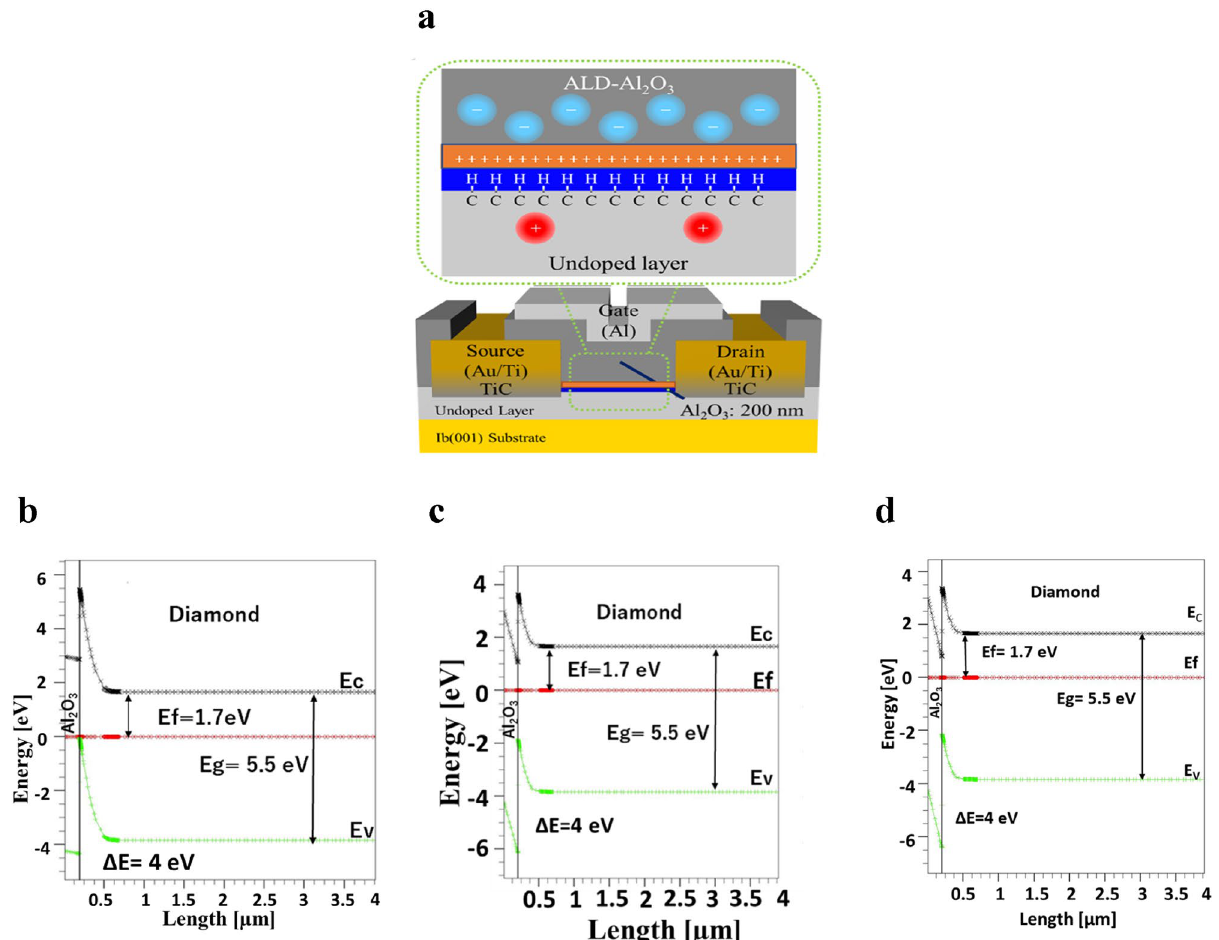
Figure 2. (a) Cross-sectional representation of the theoretical modeling 2DHG diamond MOSFET with the fixed interface charge sheet model close to surface in the FETs diamond substrate where L GD = 4 μm, L ch = 4 μm and W G = 25 μm. The upper section illustrated the negative interface charge in the ALD Al 2 O 3 . (b) , (c) , (d) The band of the C–H diamond becomes upward near the Al 2 O 3 /C-H diamond interface. In the bulk, however, Fermi level E f is fixed at 1.7 eV from the conduction band minimum corresponding to the position of nitrogen donor level (1.7 eV), which are common in the following three models withe negative, neutral, and positive interface charge sheets. (b) The negative interface charge density of 5 x 10 12 cm -2 . The valence band maximum crosses Fermi level near the Al 2 O 3 /diamond interface indicating a strong inversion layer. (c) For the no interface charge model, the valence band maximum is located at 1.8 eV from the Fermi level at the interface. It indicates a weak inversion layer. (d) The positive interface charge density of 1 x 10 11 cm -2 . The valence band maximum forms an upward band bending, but cannot reach the Fermi level. It is located at 2.1 eV from the Fermi level at the interface. The band diagram is also classified as a weak